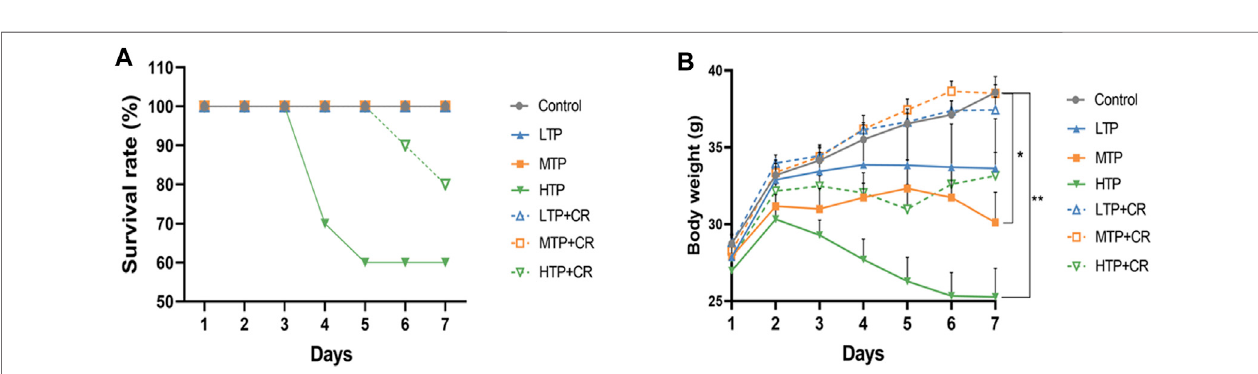
Frontiers in Pharmacology |